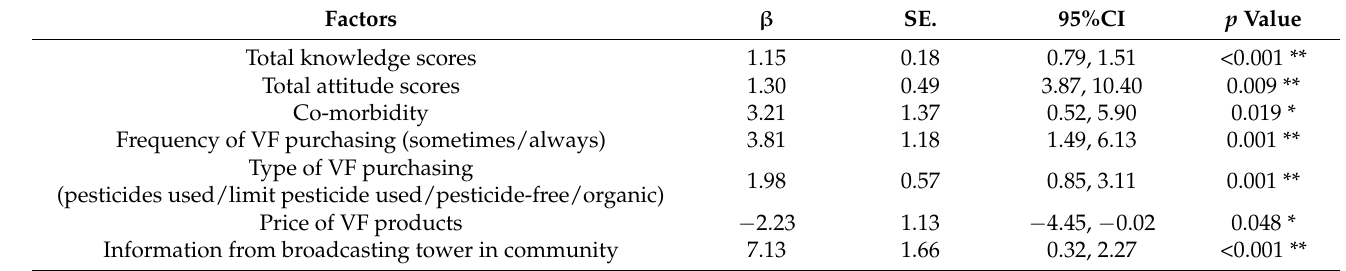
Table 3. Factors associated with consumers’ behavior in reducing pesticide residues in VF ( n =